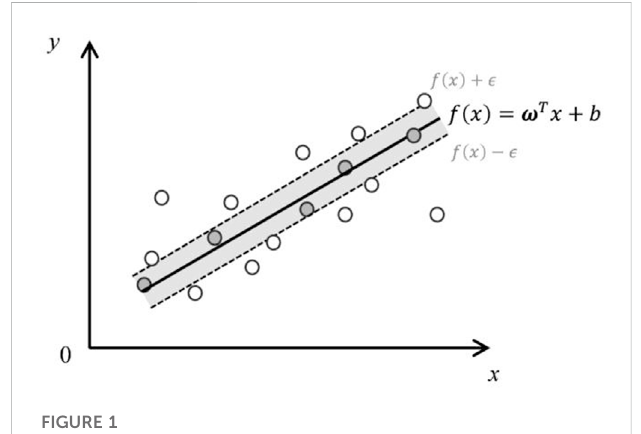
FIGURE 1 Schematic diagram of the SVR algorithm.